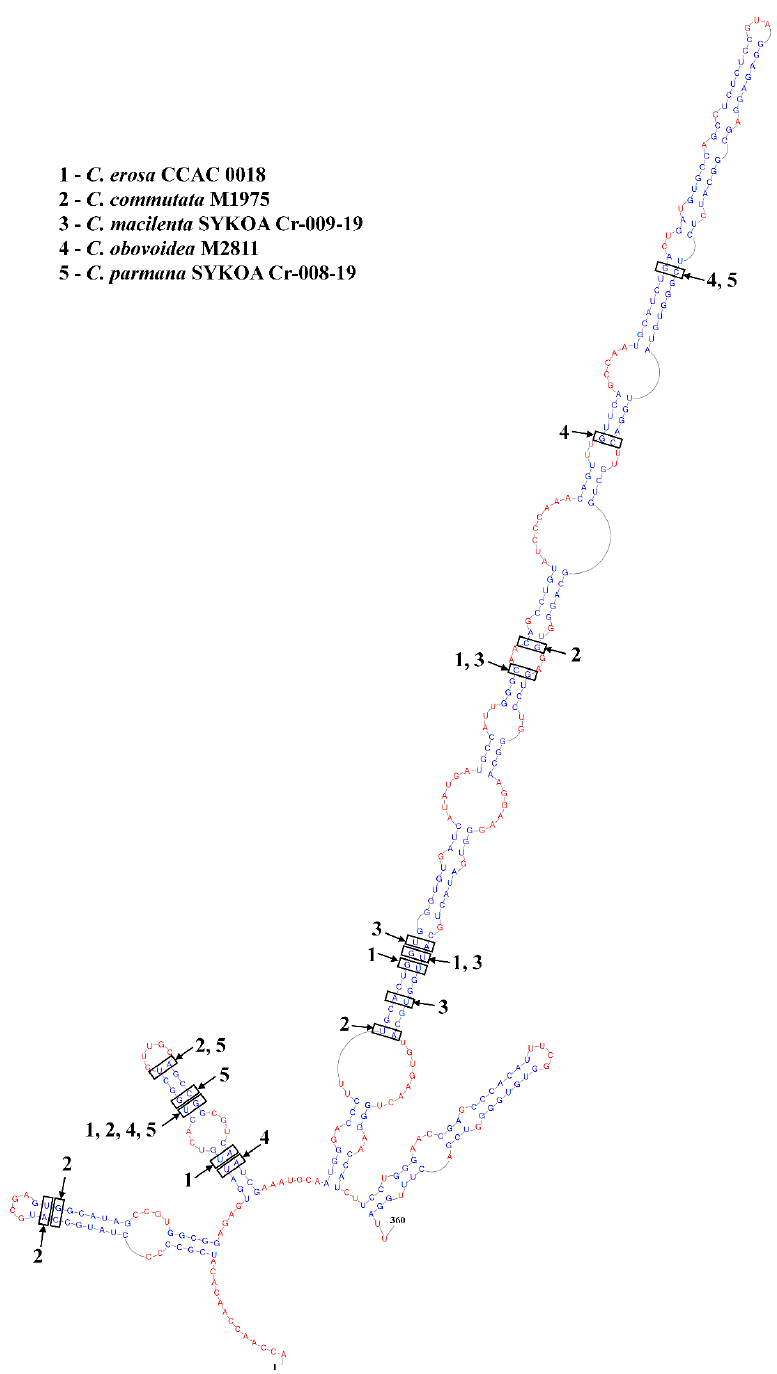
Figure 4. Predicted ITS2 secondary structure model of the strain Vp 376 of Cryptomonas tropica . Compensatory Base Changes between this species and some related, indicated by numbers, are marked by black boxes.